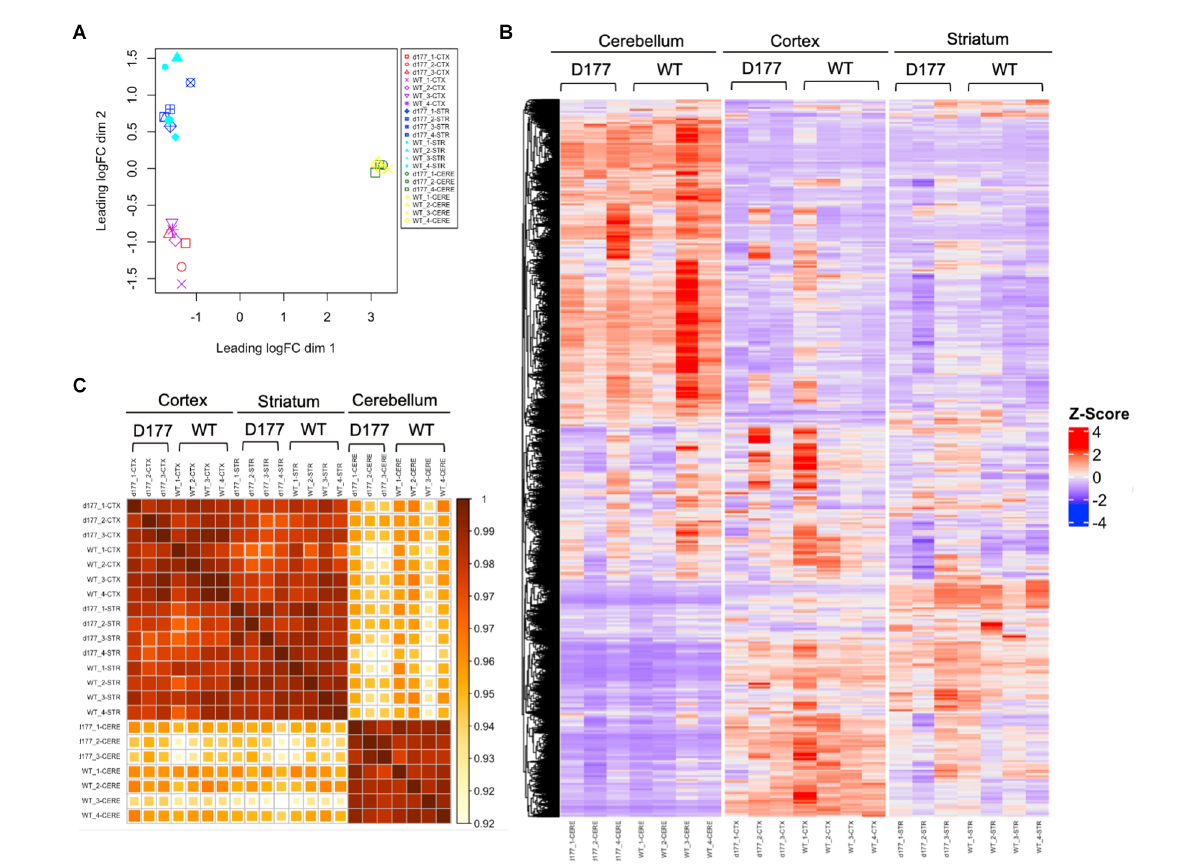
FIGURE4 RNA-seq analysis of gene expression in D177 and wild type mice. (A) The MDS plot shows that the same brain region samples of D177 and WT mice present low dispersion. (B) The Heat map of top 1,000 DEGs (adjust. P -value < 0.05, Benjamini–Hochberg, two-sided) upon cortex, striatum, and cerebellum samples of D177 and WT mice. Red indicates increased expression; blue indicates reduced expression. The intensity of the color reflects the degree of gene regulation. (C) The corresponding correlation coefficients between each sample are plotted through heatmap. The scale bar indicates correlation coefficients from 0.9 to